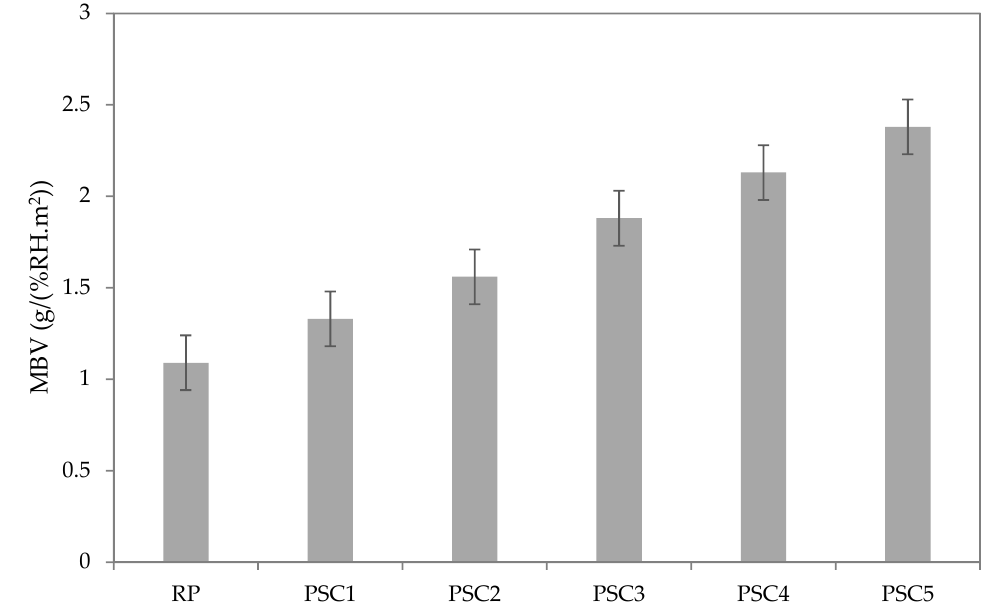
Figure 8. Comparison of moisture-buffering values of studied plasters.